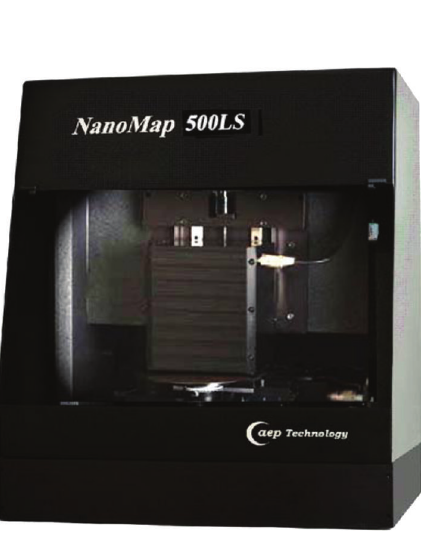
Figure 9: NanoMap 500LS.